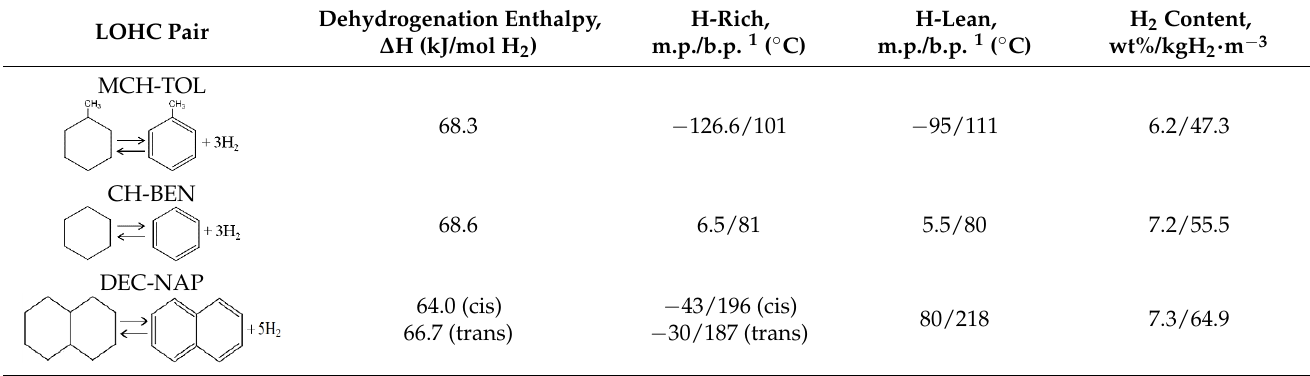
Table 1. Physical and thermodynamic properties of some liquid organic hydrogen carriers (LOHCs) [18,30].